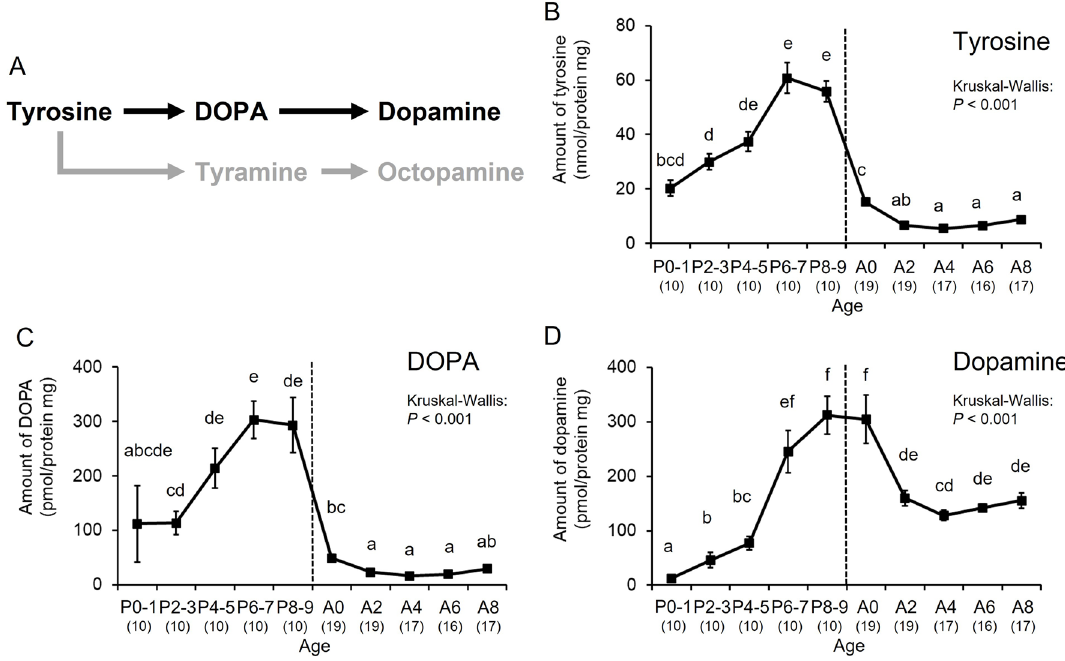
Figure 1. Age-dependent changes in dopamine-related substances normalized by brain protein in bumble bee males. ( A ) Synthetic pathway for dopamine-related substances. Levels are shown of tyrosine ( B ), DOPA ( C ), and dopamine ( D ) in the brain. Error bars indicate standard errors. Significant differences according to the Steel– Dwass test ( P < 0.05) are indicated by different letters. Sample sizes are shown in